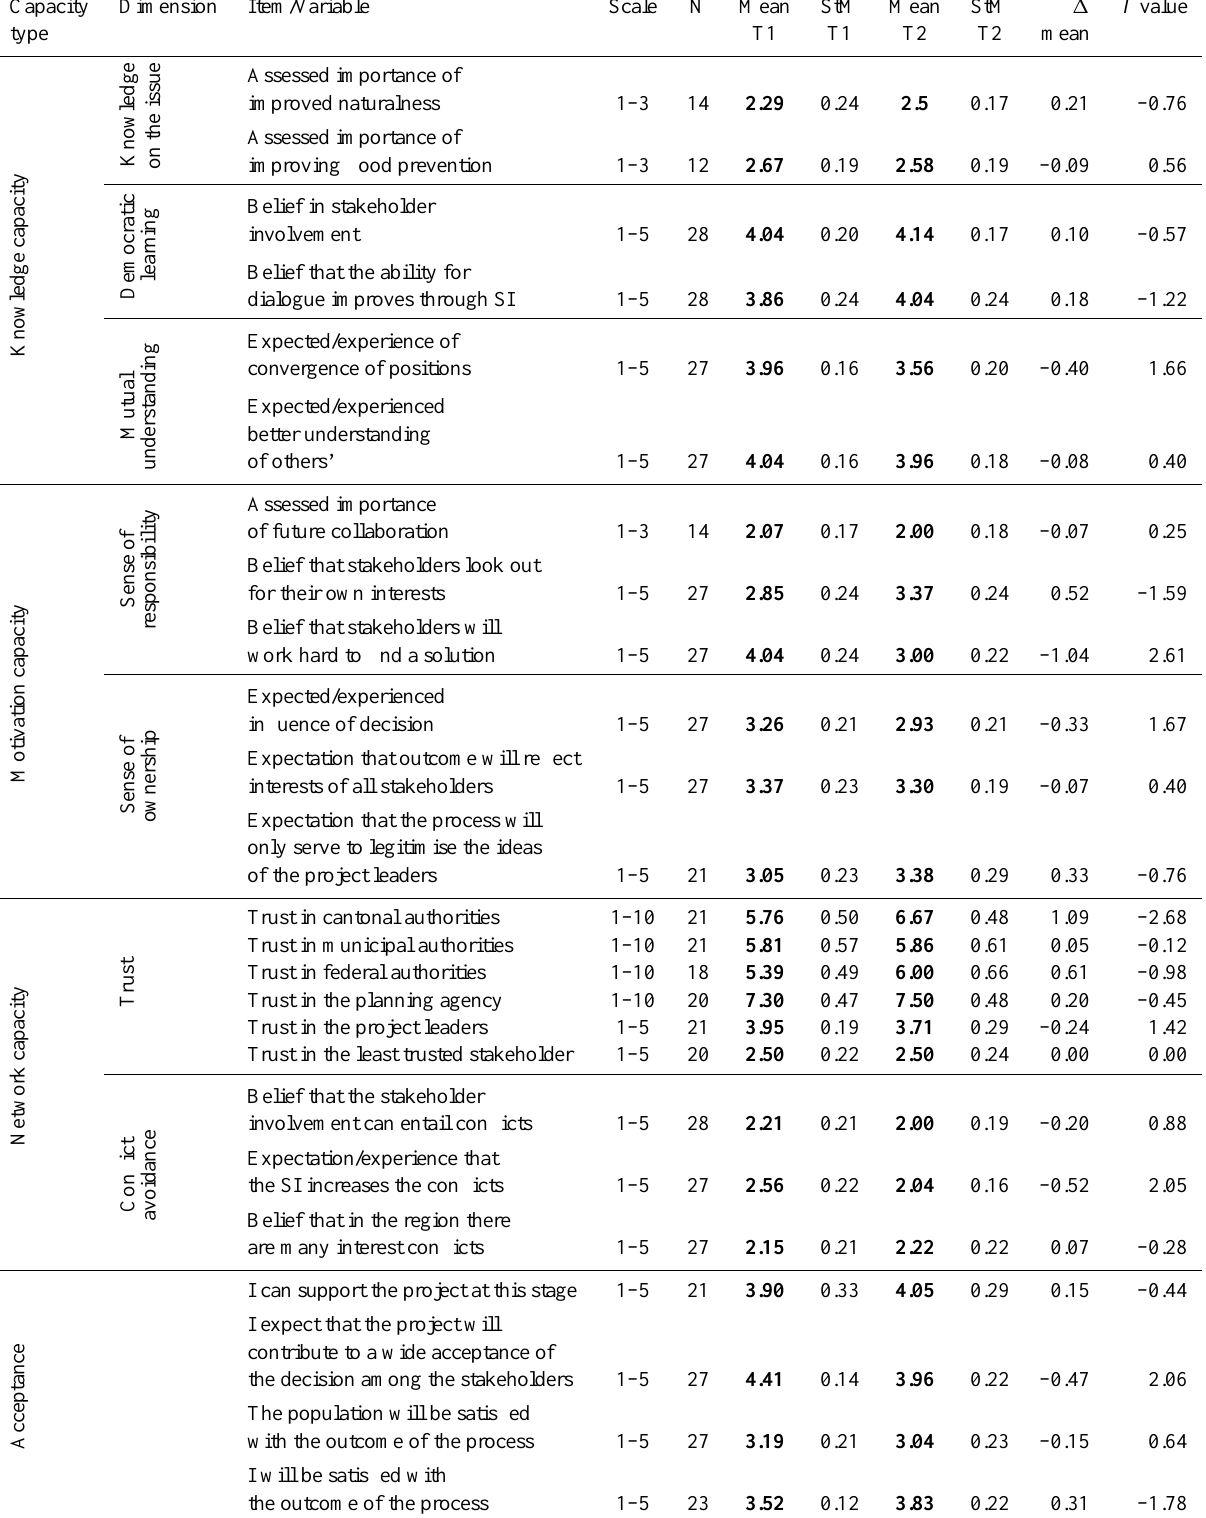
Table 2. The respondents’ perceived social capacities and acceptance of the project in the early (T1) and later (T2) phase of the stakeholder involvement process. Analysis of means of the paired sample. Mean values T1 and T2 are in